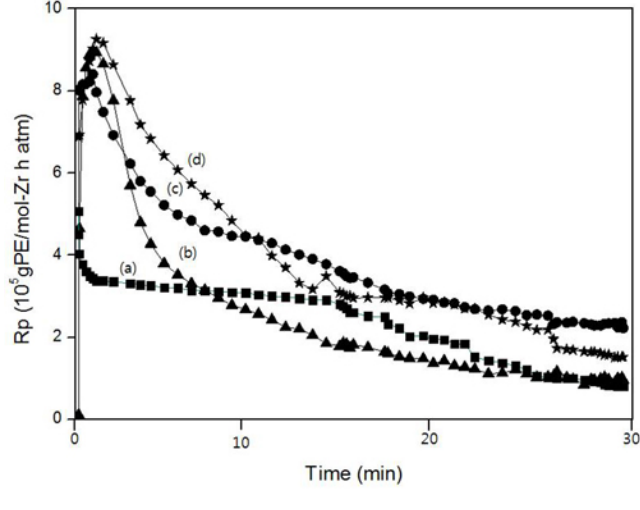
Figure 8. A comparison of the polymerization rate ( R polymerization time: ( a ) PE; ( b ) PEM; ( c ) PED and ( d )